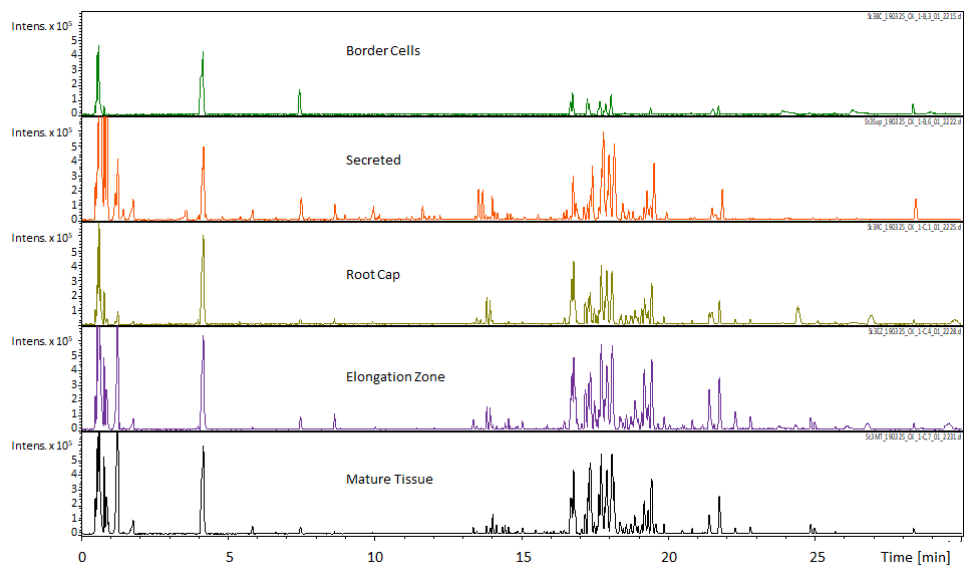
Figure 1. Comparison of UHPLC-MS chromatograms obtained for different M. truncatula root tissues (scale × 10 5 ). The Umbelliferone internal standard can be seen immediately after the 4 min time point. Observational comparison of the five sampled regions revealed differential accumulation of metabolites with the most readily apparent differences in the 0 to 2 min and 16 to 19 min time span. These qualitative data indicate differential accumulation of metabolites that can potentially be linked to specialized functions.